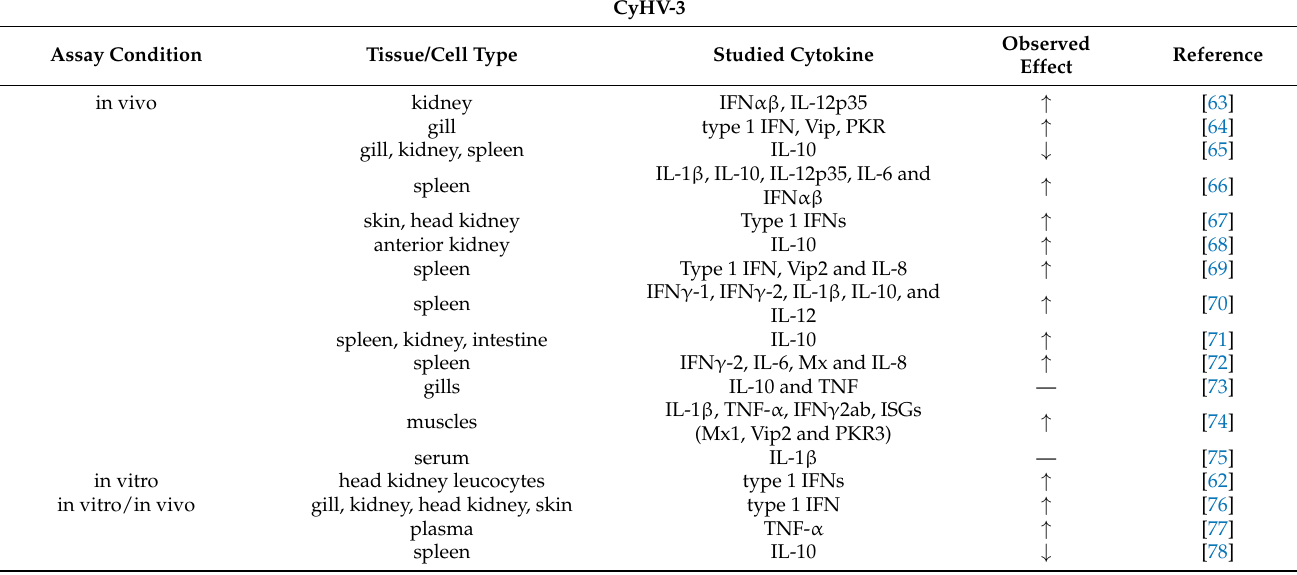
Table 1. List of cytokines studied during cyprinid herpesvirus 3 (CyHV-3), spring viremia of carp virus (SVCV), carp edema virus (CEV), and Aeromonas hydrophila ( A. hydrophila ) infections in common carp ( C. carpio